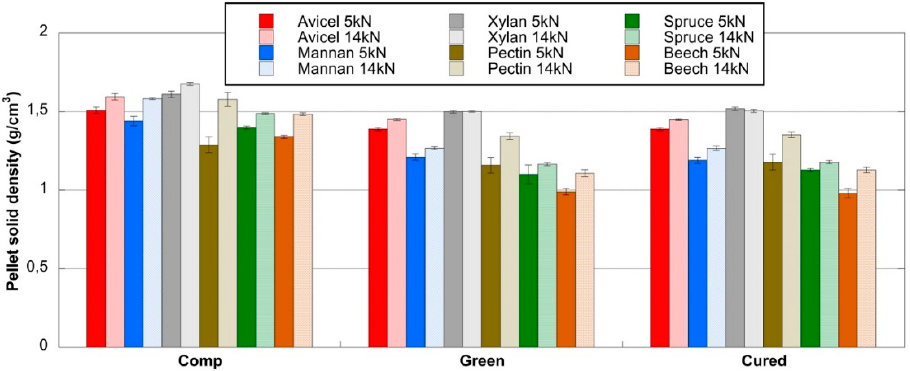
Figure 5. Length expansion for cured pellets in comparison with compressed pellets for up to 5 kN and 14 kN at a varied moisture content: ( a ) Sti ff er polysaccharides cellulose and mannan, ( b ) more flexible polysaccharides xylan and pectin, and ( c ) softwood and hardwood.